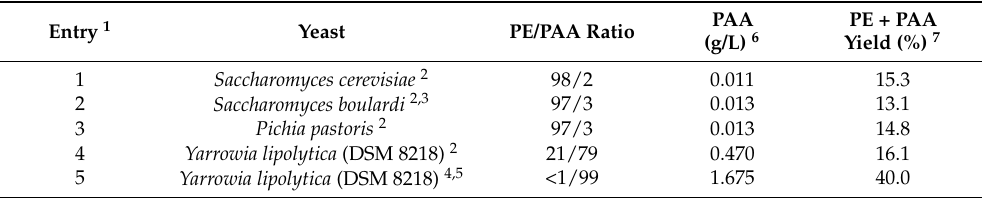
Table 1. Biotransformation of (L)-phenylalanine with short contact time and low